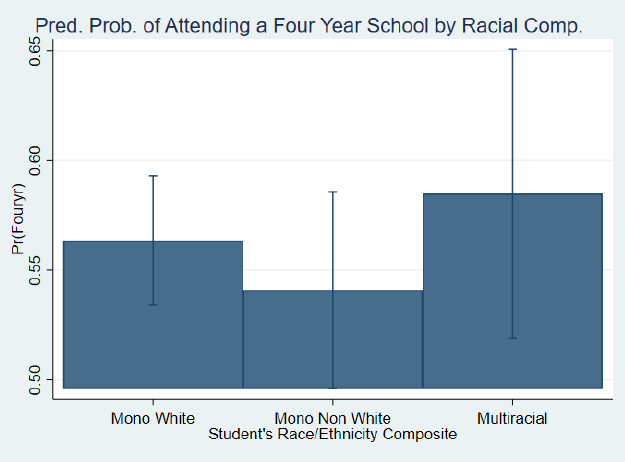
Figure 5. Pred. Prob. of Two Year v Four Year Choice by Racial Comp. using ELS data.